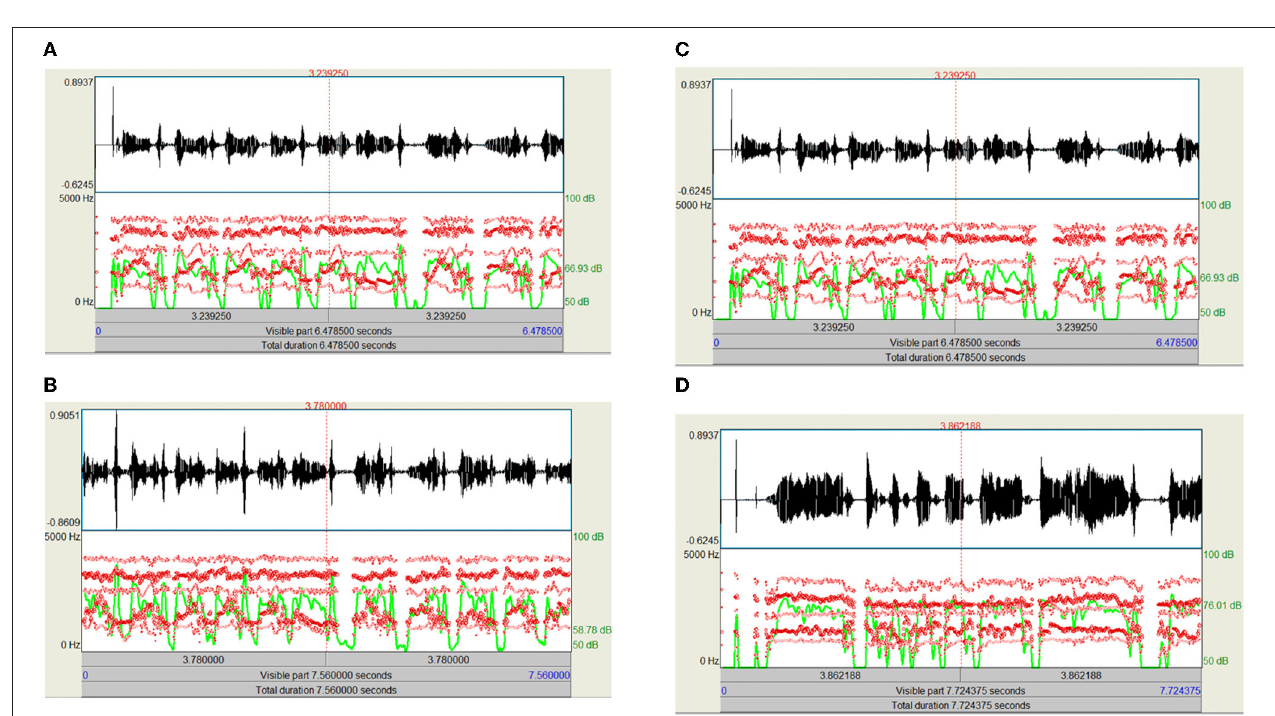
FIGURE 2 | (A) Audio signal of a sample baby cry (diaper) with intensity (green) and formant information (red), (B) audio signal of a sample baby cry (hunger) with intensity (green) and formant information (red), (C) audio signal of a sample baby cry (pain) with intensity (green) and formant information (red), and (D) audio signal of a sample baby cry (sleep) with intensity (green) and formant information